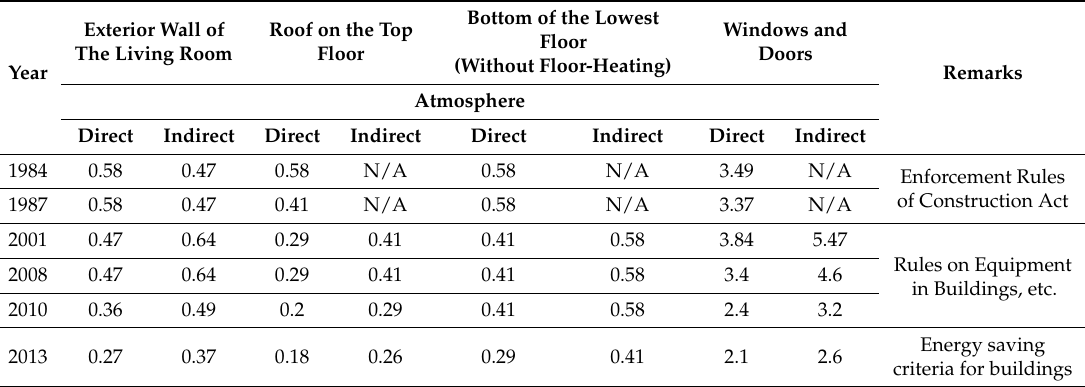
Table 9. Changes in the thermal transmittance of envelope design criteria in South Korea (Central region, not including multi-unit houses or apartments) (Unit: W/m 2 · K).